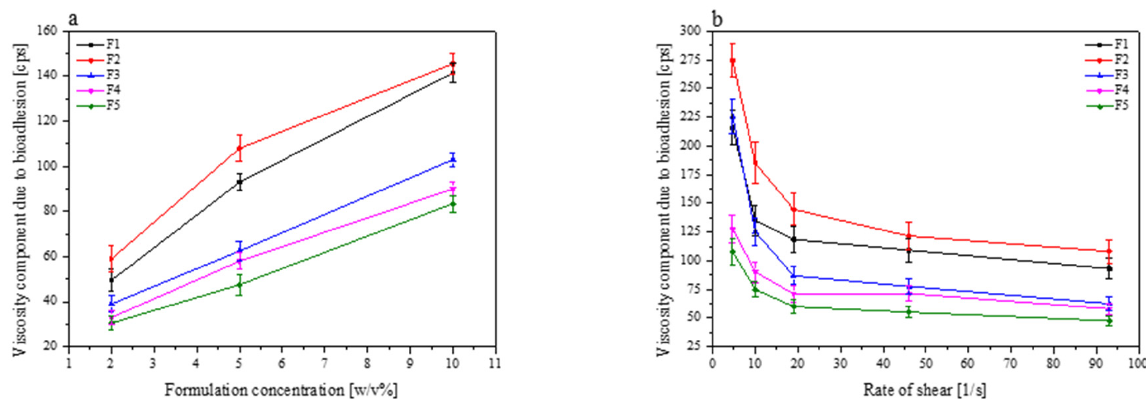
Figure 8. The effect of the polymer concentration (2–10%) on the viscosity component due to bioadhesion for formulations F1–F5 at a rate of shear 93 1/s ( a ), and the effect of the rate of shear on the viscosity component due to bioadhesion for 5% of formulations F1–F5 ( b ).